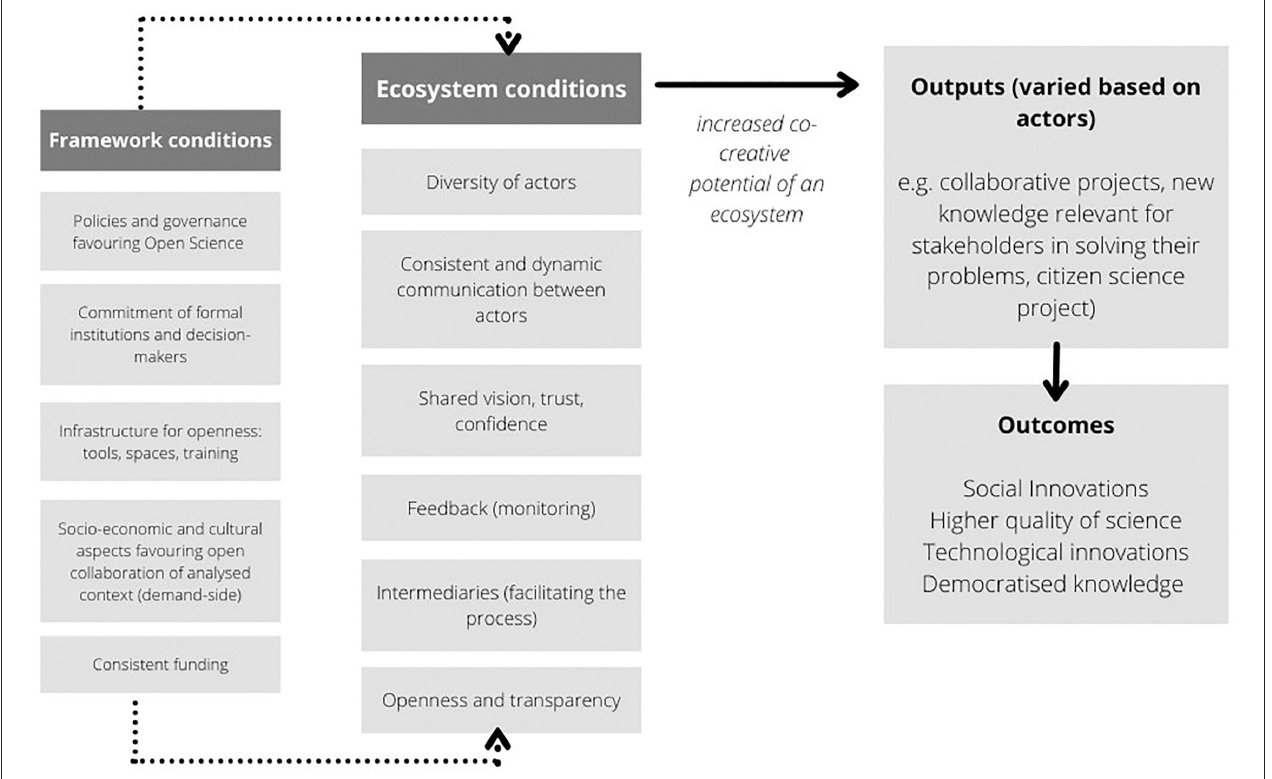
Frontiers in Communication |